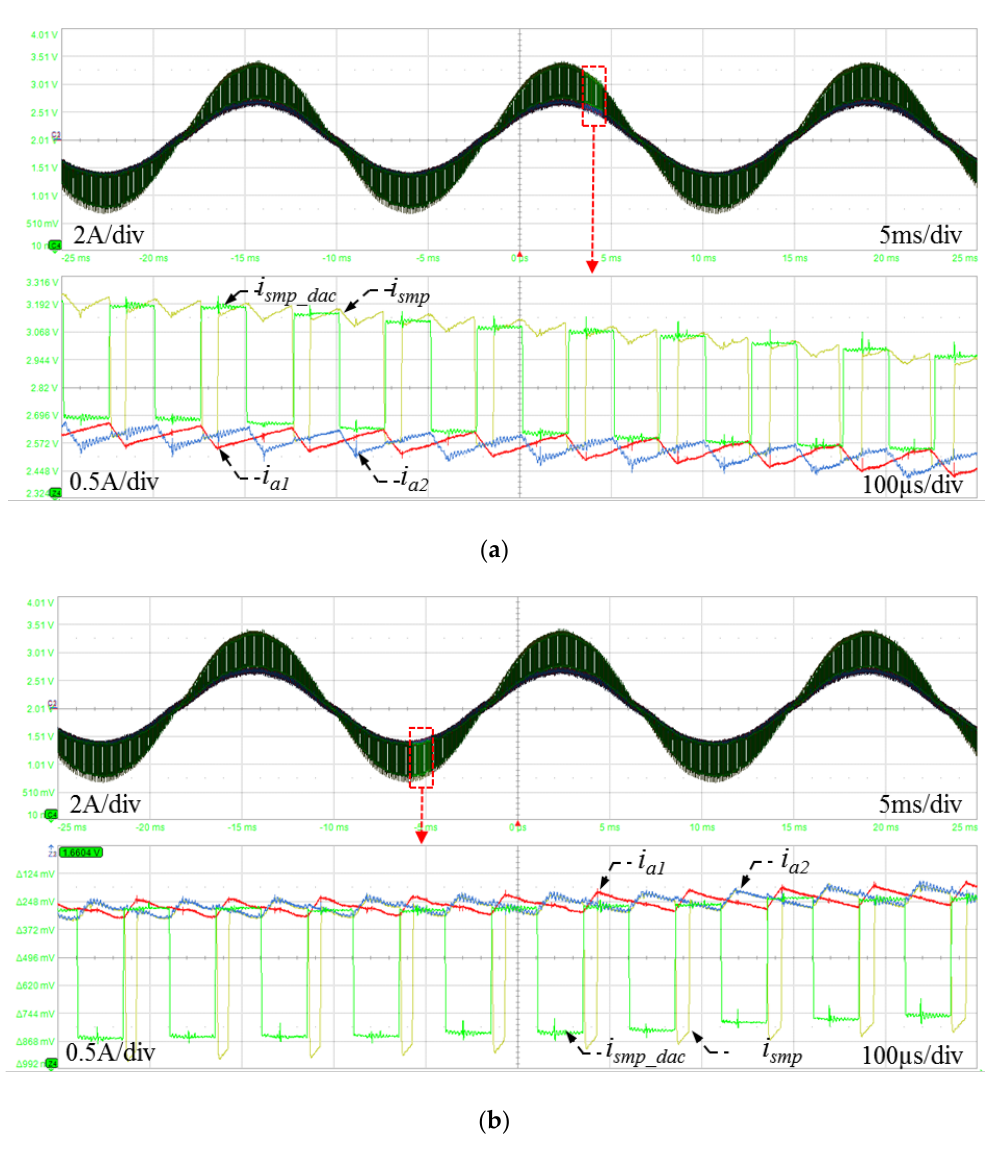
Figure 7. Experimental results. ( a ) The actual current and sampled current when the phase A current is positive. ( b ) The actual current and sampled current when the phase A current is negative.